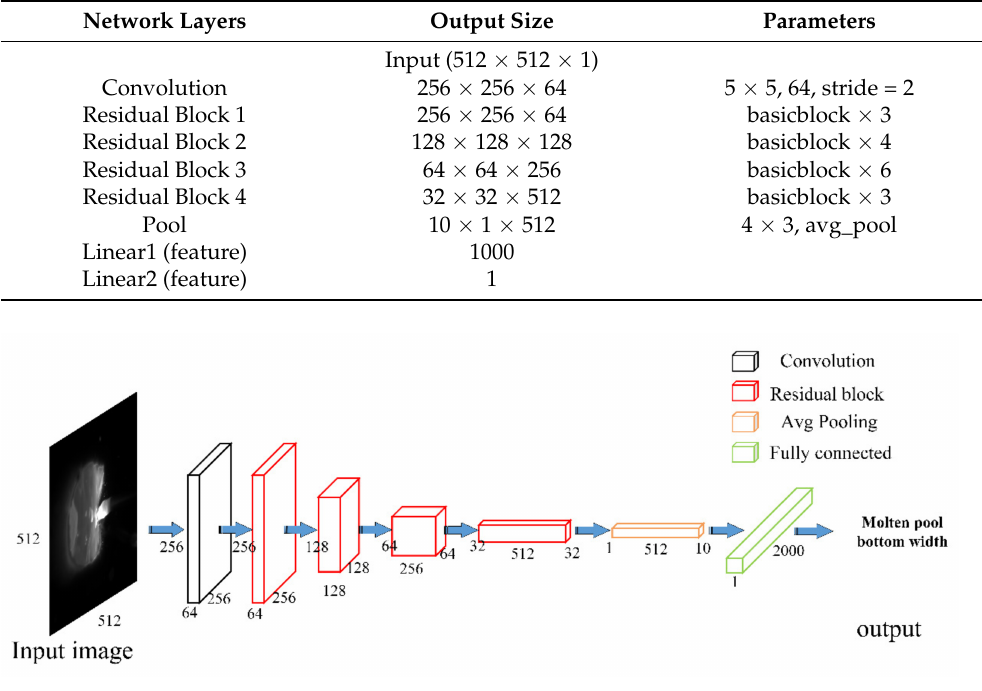
Figure 4. Prediction network structure diagram of the bottom molten pool